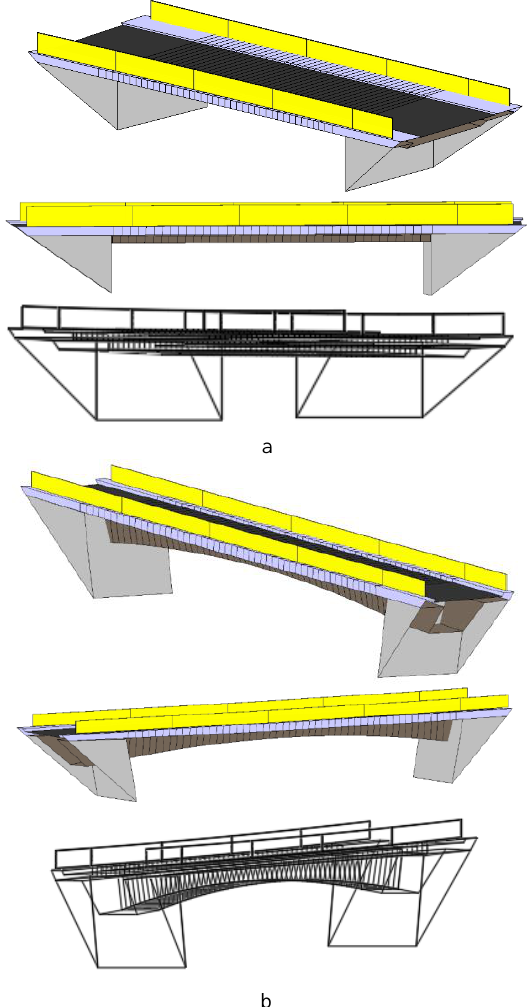
Figure 16. 3D models: a: bridge 1; and b: bridge 2.